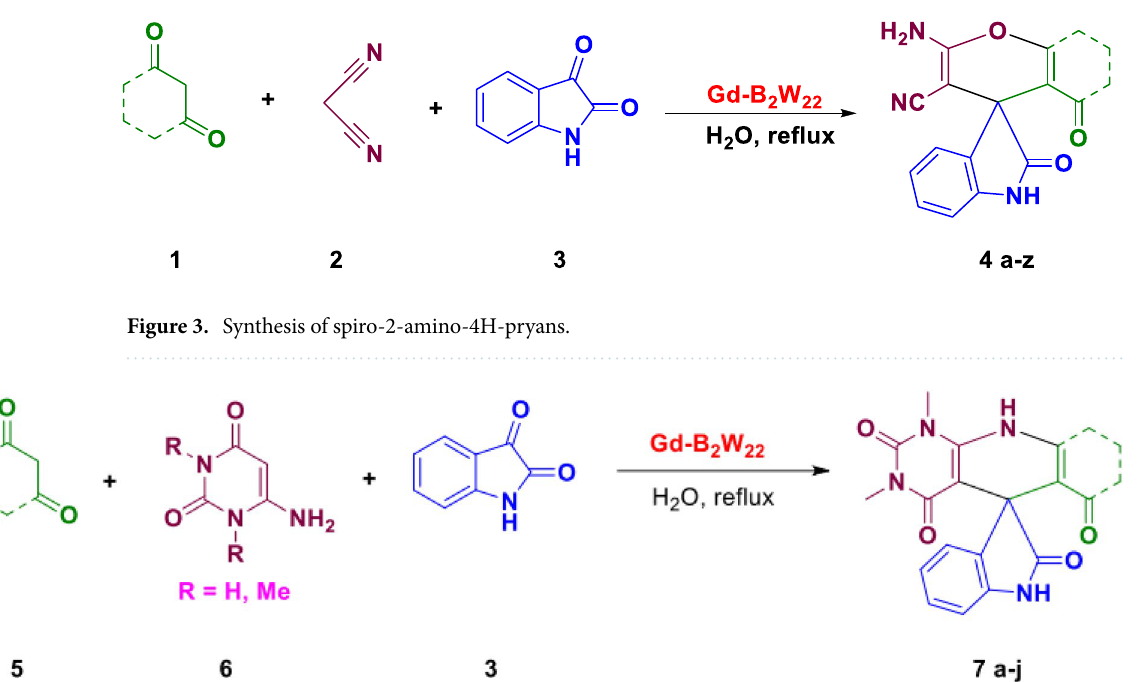
Figure 4. Synthesis of uracil-fused